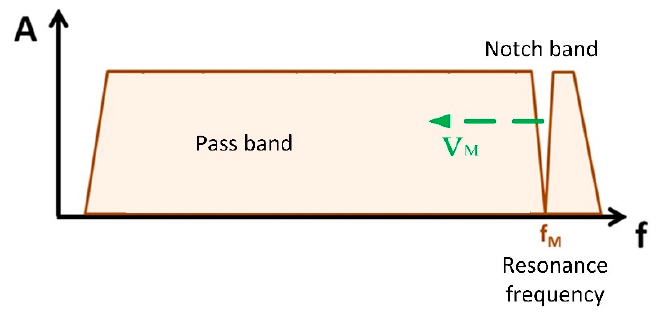
Figure 8. Frequential response of an EB device.